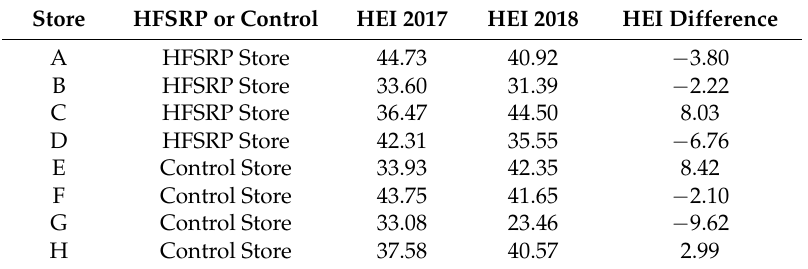
Table 5. Healthy Eating Index (HEI) scores for control and HFSRP stores in 2017 and 2018. Store HFSRP or Control